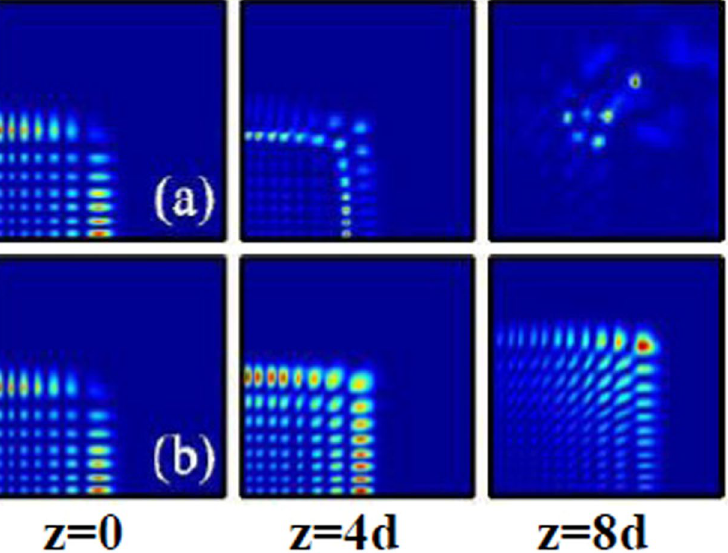
Figure 5. The intensity distributions of a vortex Airy beam at different propagation distances in ( a ) local nonlinear ( σ = 0) and ( b ) nonlocal nonlinear media, respectively. The initial parameters are m = 1, x 0 = y 0 = 0, and A = 8, respectively. The degree of nonlocality of Fig. 5(b) is σ =